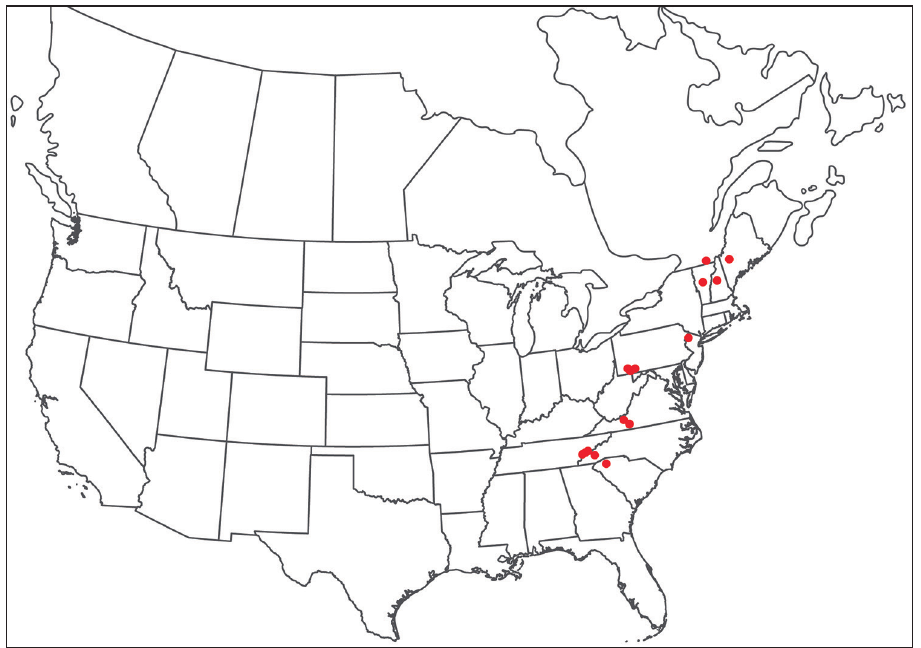
Figure 50. Torrenticola delicatexa